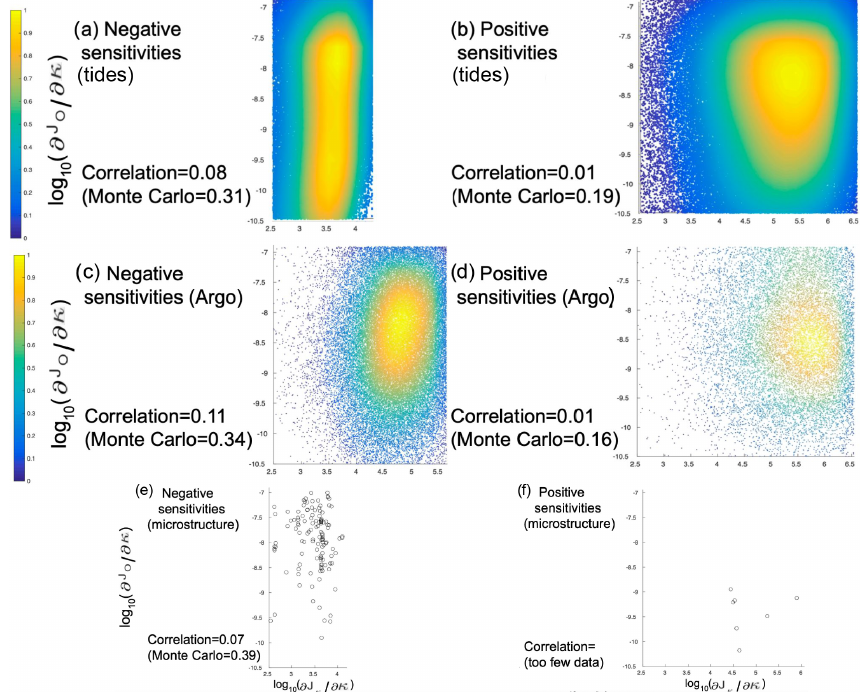
Figure 12. Shown are scatterplots between the adjoint sensitivities from E O and E κ where they are both negative ( panels a , c , and e) and where they are both positive ( panels b , d , and f) . E κ has its adjoint sensitivities calculated with the tidal mixing product κ ρ, tides ( panels a and b) , Argo-derived κ ρ ( κ ρ, Argo and κ ρ, CTD ; panels c and d) , or microstructure-inferred κ ρ ( panels e and f) . Only the adjoint sensitivities for which the differences between κ ρ, ECCO and observational κ ρ products are statistically significant (greater than a factor of 3) and when the differences between oxygen concentrations from ECCO and those from the World Ocean Atlas (2013) are statistically insignificant (within 2% of the latter) are included. The correlations for all of the data points shown in each panel are listed. Also listed below each panel are the maximum possible correlations from a Monte Carlo-based approach in which 10000 random samples of κ ρ within the uncertainties of the observational κ ρ products are used to recompute the adjoint sensitivities for E κ